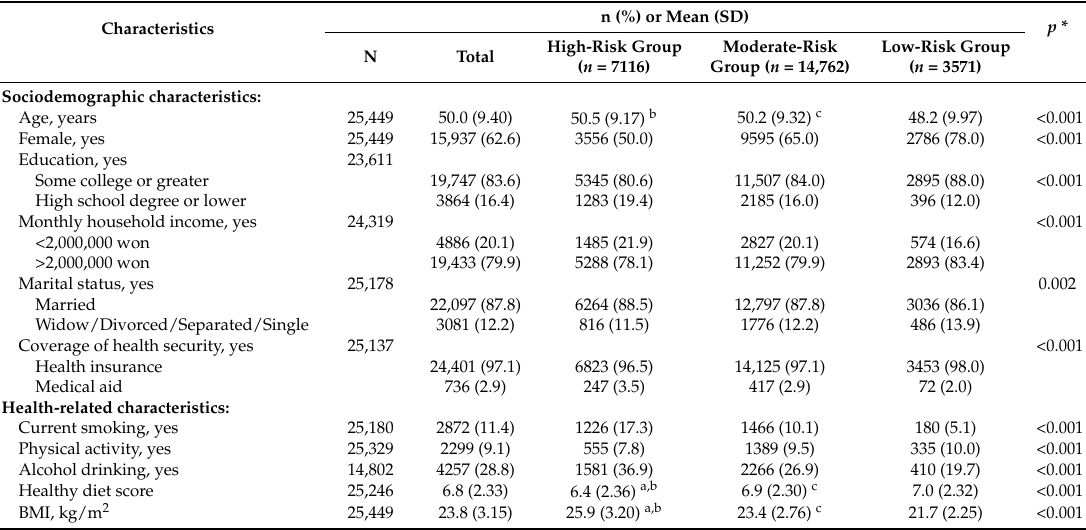
Table 1. General characteristics of participants, stratified by group ( N =